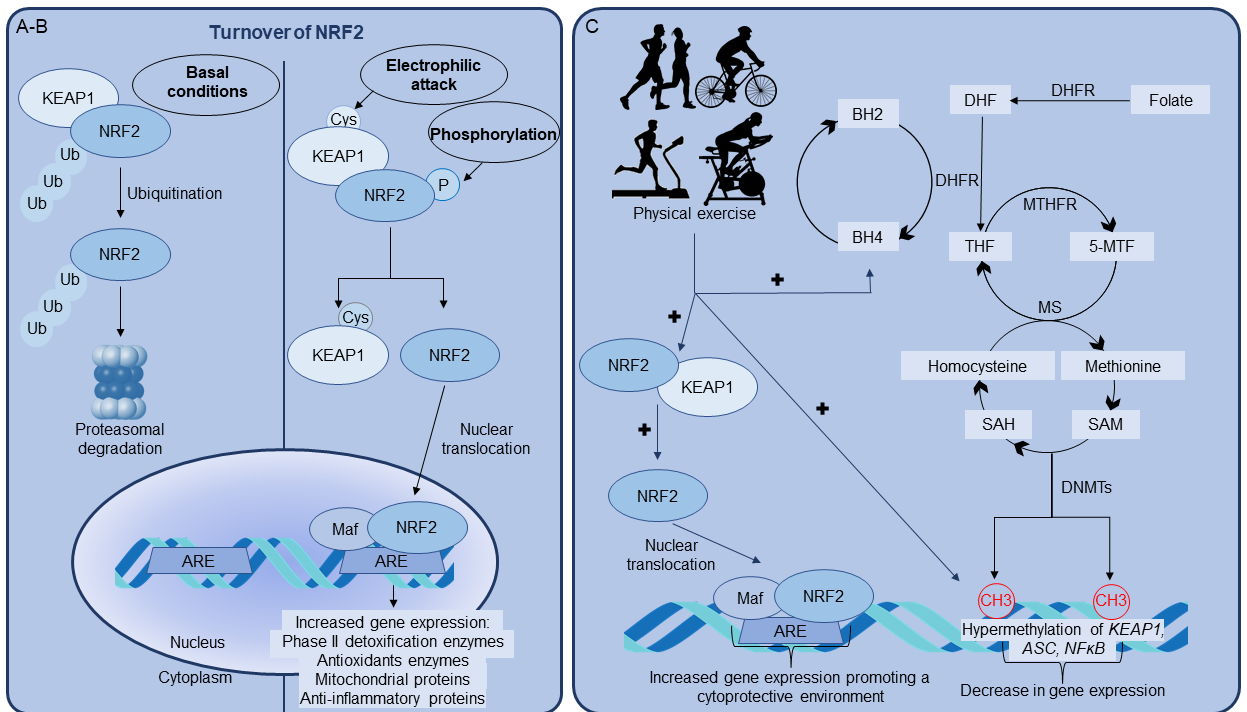
Figure 1. Regulation of the erythroid-related-nuclear-factor-2 (NRF2) pathway mediated by physical exercise. ( A ) Under basal conditions, cytosolic NRF2 is maintained at low levels by ubiquitin-mediated proteasomal degradation. ( B ) Electrophilic stress and NRF2 phosphorylation can induce NRF2 nuclear translocation and further interaction of the transcription factor with the antioxidant-responsive element (ARE). The interaction with ARE mediates the transcriptional activation of many genes encoding phase II drug-metabolizing and antioxidant enzymes, or proteins that will enhance mitochondrial activity and number, and promote an anti-inflammatory status. ( C ) Signaling pathways activated by physical exercise. The regular practice of physical exercise positively regulates NRF2 nuclear translocation, the synthesis of tetrahydrobiopterin (BH4) and epigenetic modifications, including DNA methylation. DNA methylation could be the result of an interplay among methionine, folate and BH4 pathways. Folate is transformed into tetrahydrofolate (THF) by the enzyme dihydrofolate reductase (DHFR), the same enzyme that catalyzes the reduction of dihydrobiopterin (BH2) into BH4 in the BH4 biosynthetic pathway. THF is transformed to 5-methyltetrahydrofolate (5-MTF) by MTHFR and converted back to THF by methionine synthase (MS), allowing the methylation of homocysteine to methionine. The latter is then transformed into S-adenoslymethionine (SAM), which can donate a methyl group for DNA methylation, leading to the formation of S-adenosylhomocysteine (SAH) and methylated DNA. The enzymes involved in DNA methylation are DNA methyltransferases (DNMTs), which transfer the methyl group from SAM to DNA, leading to methylation of the promoter region of KEAP1 gene, decreasing its expression and favoring NRF2 translocation. In addition, the hypermethylation of the promoter region of the ASC gene and NFkB , which encode proteins involved in promoting an anti-inflammatory status, will promote an anti-inflammatory environment.